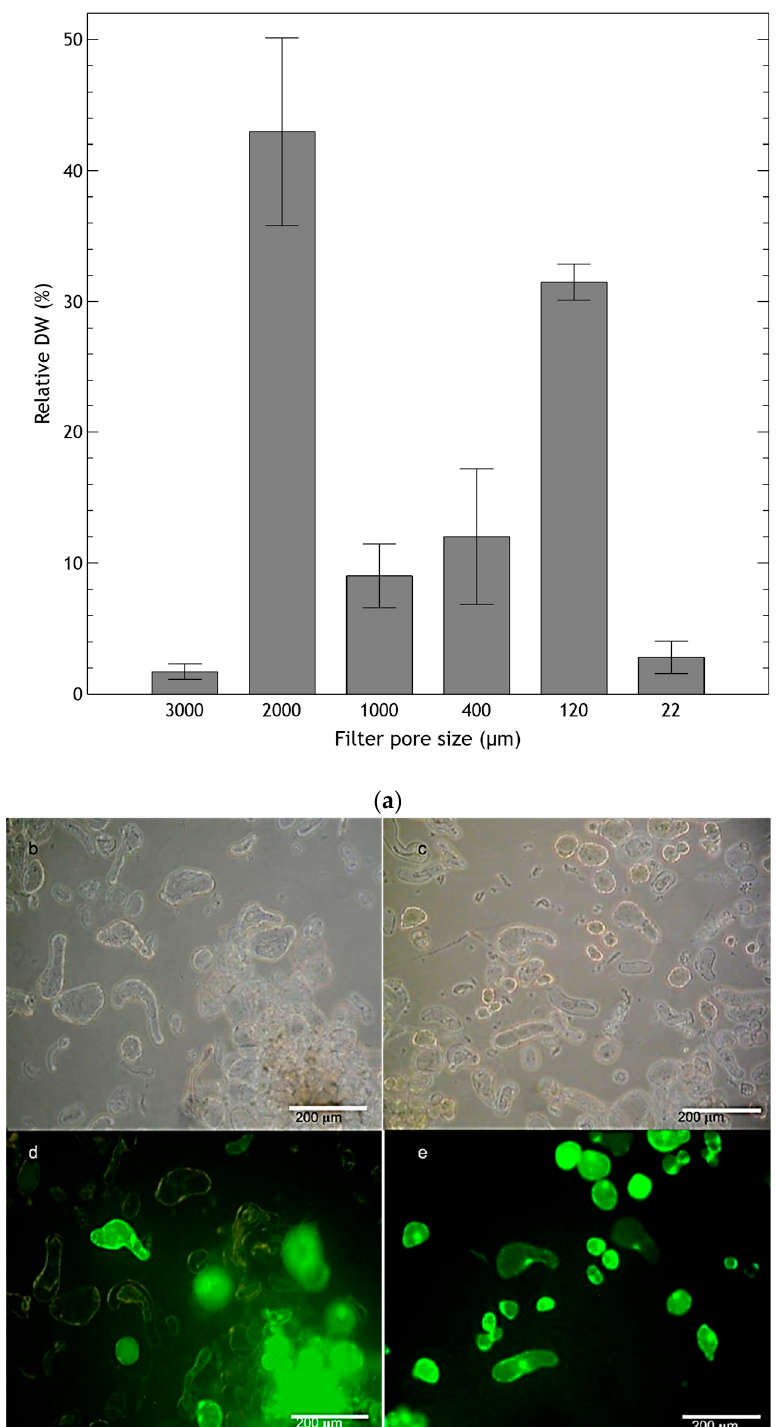
Figure 4. ( a ) Size of clusters of cell suspension culture of Helianthella quinquenervis analyzed at the stationary phase (eighth day). Results are expressed as the percentage of DW retained in each filter. Values are means ± S.D. of five measurements; ( b – e ) viability of two suspension culture fractions obtained by differential filtration with 2 mm mesh ( b , d ), and homogenous cultures obtained with 22 μ m mesh ( c,e ) during the end of the exponential phase and the start of the stationary phase; b and c, with light field; d and e, with fluorescence microscopy.